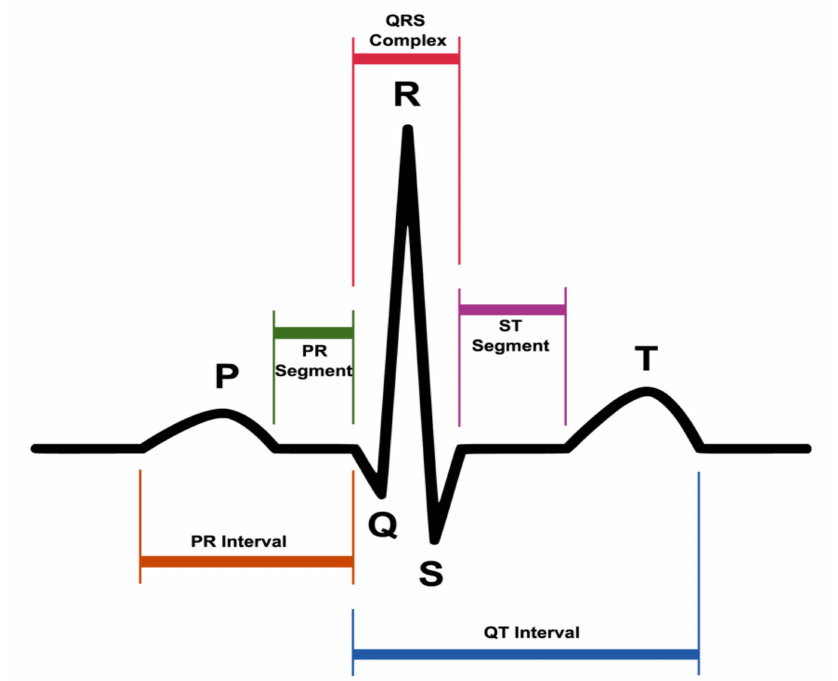
Figure 1. A typical electrocardiogram (ECG) waveform and its characteristic patterns (P and T waves, PR and ST segments, PR and QT intervals, as well as the QRS